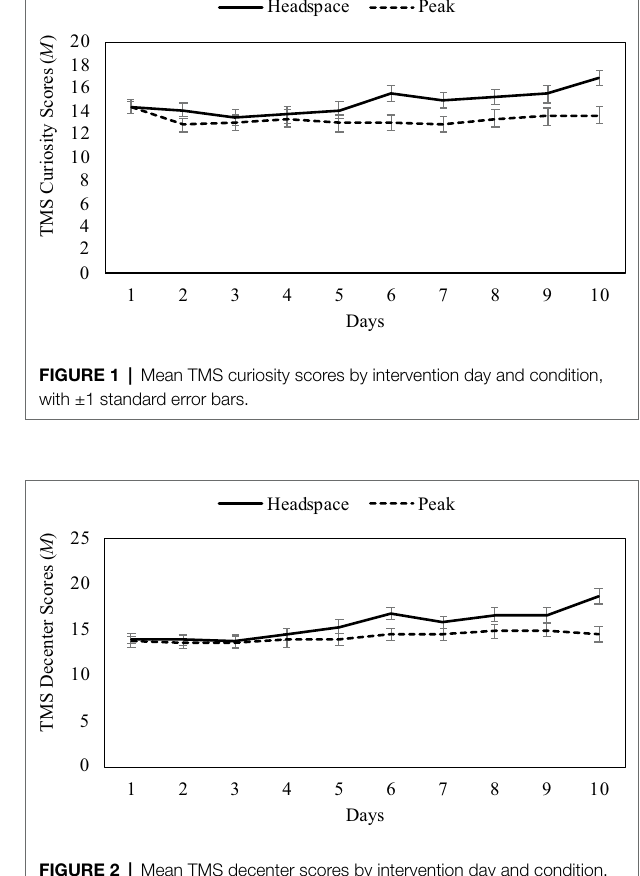
FIGURE 2 | Mean TMS decenter scores by intervention day and condition, with ±1 standard error